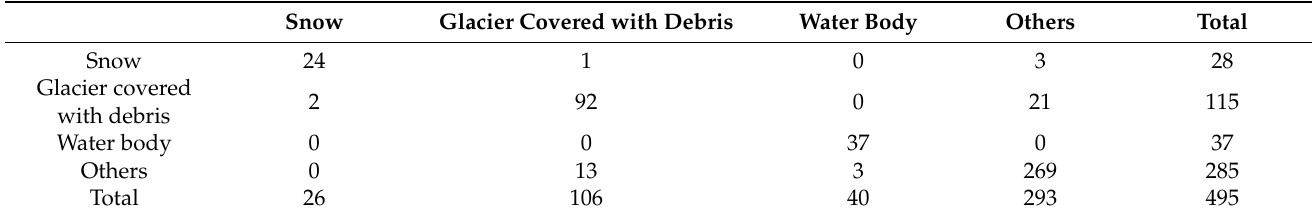
Table 5. Results of the second classification verification